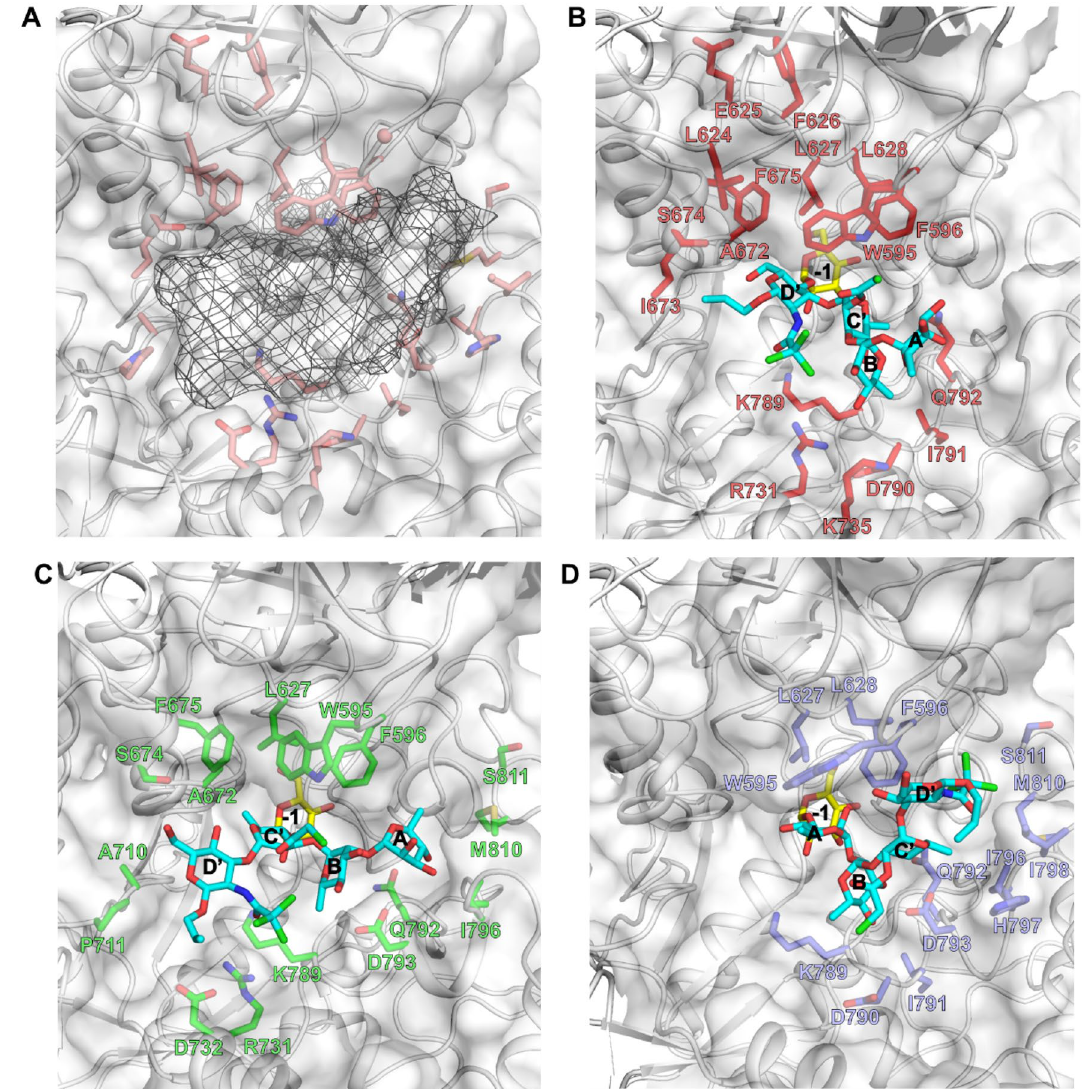
ABC’[E(1 → 4)]D’ ( S. flexneri 1a/1b) targeted by mutants M1-M16 from Group I is shown in ( B ); AB[E(1 → 4)] C’D’ ( S. flexneri 2a) targeted by mutants M17-M34 from Group II is shown in ( C ); [E(1 → 3)]ABC’D’ ( S. flexneri 3a) targeted by mutants M35-M49 from Group III is shown in ( D ). Molecular graphics were prepared using PYMOL 1.7 (PyMOL Molecular Graphics System, Schrödinger,